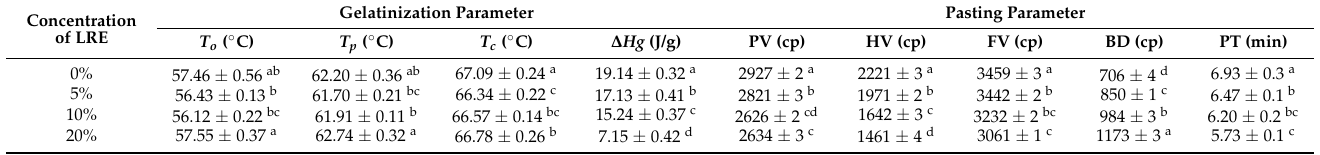
Table 1. The effect of LRE on the thermodynamic properties and pasting characteristics of wheat starch. Gelatinization Parameter Pasting Concentration of LRE